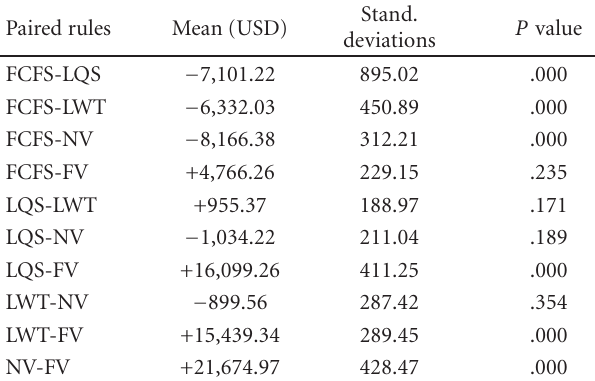
Table 5: Results of the paired t -test for di ff erent dispatching rules for average annual profit.